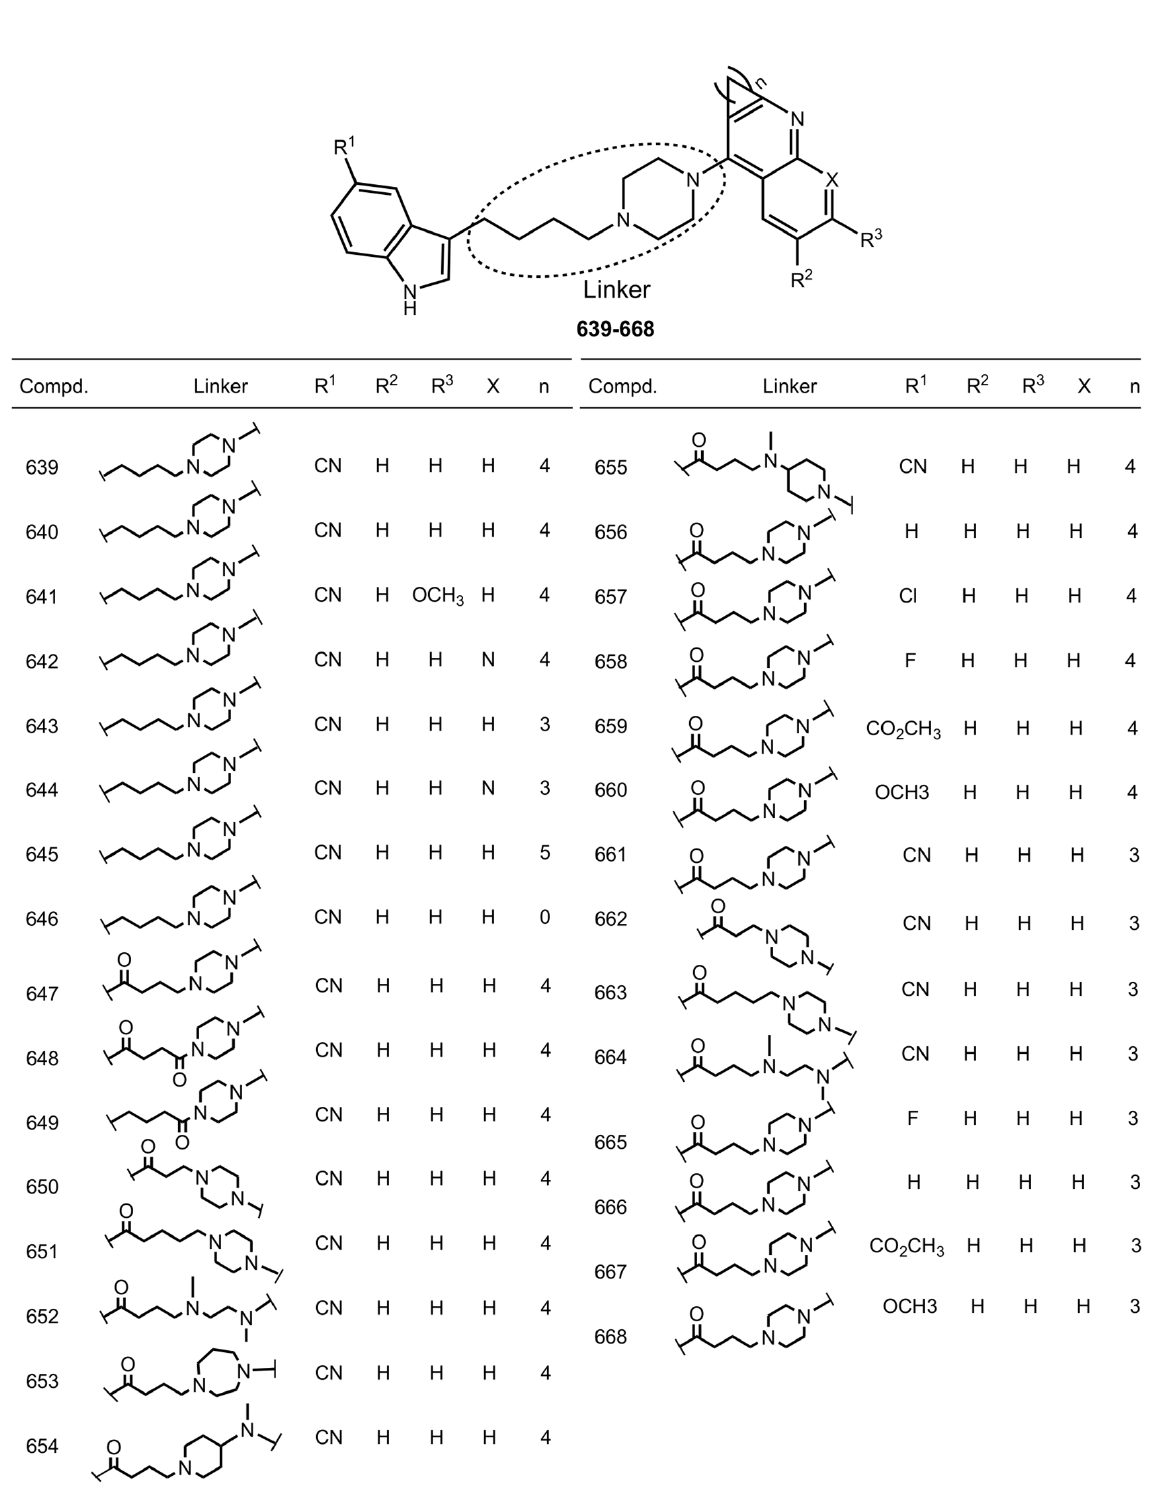
Figure 26. THA–Vilazodone hybrids 639 – 668 [102]. In 2017, Li et al. reported hybrids of THA with Vilazodone 639 – 668 , an inhibitor of serotonin reuptake and partial agonist of 5 ‐ HT 1 A receptor [102,189] (Figure 26). Activities of hybrids such as 5 ‐ HT 1 A agonists and 5 ‐ HT reuptake inhibitors were evaluated; hybrid 643 showed relatively balanced activities against the three targets. Low hepatotoxicity of 643 was confirmed on HepG2 cells. Low cardiotoxicity of 643 was con ‐ firmed by hERG activity inhibition. The antidepressive effect of 643 was confirmed by the